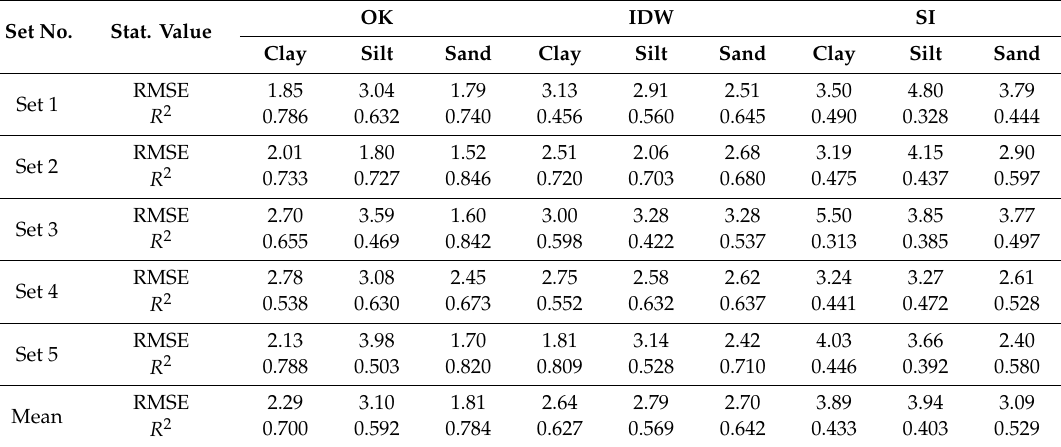
Table 4. Accuracy assessment of the evaluated interpolation methods per soil parameter. Set No.